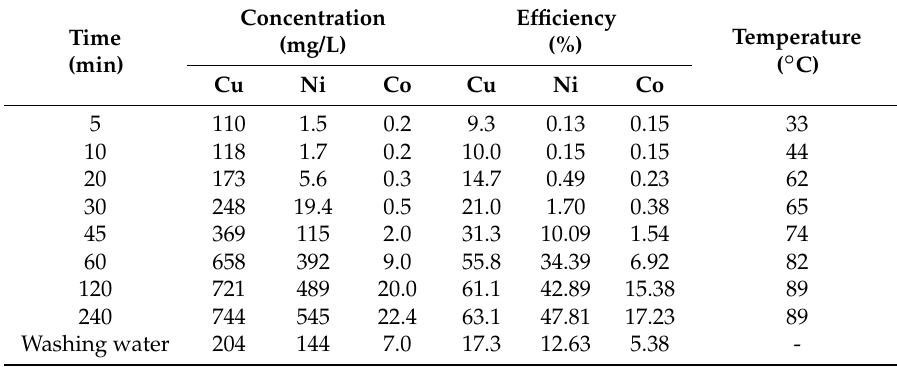
Table 11. Metals concentration and extraction efficiency of ammoniacal leaching with ultrasound and microwave (60 W).